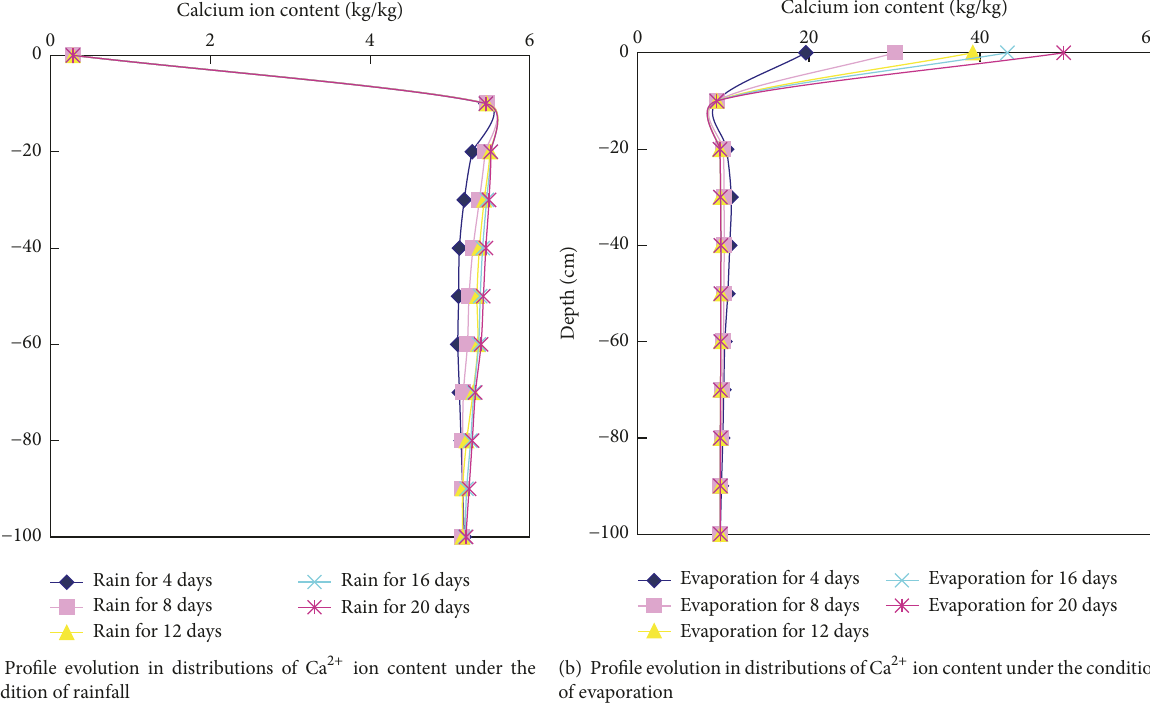
Figure 6: Distributions of Ca 2+ ion content under conditions of continuous rainfall and